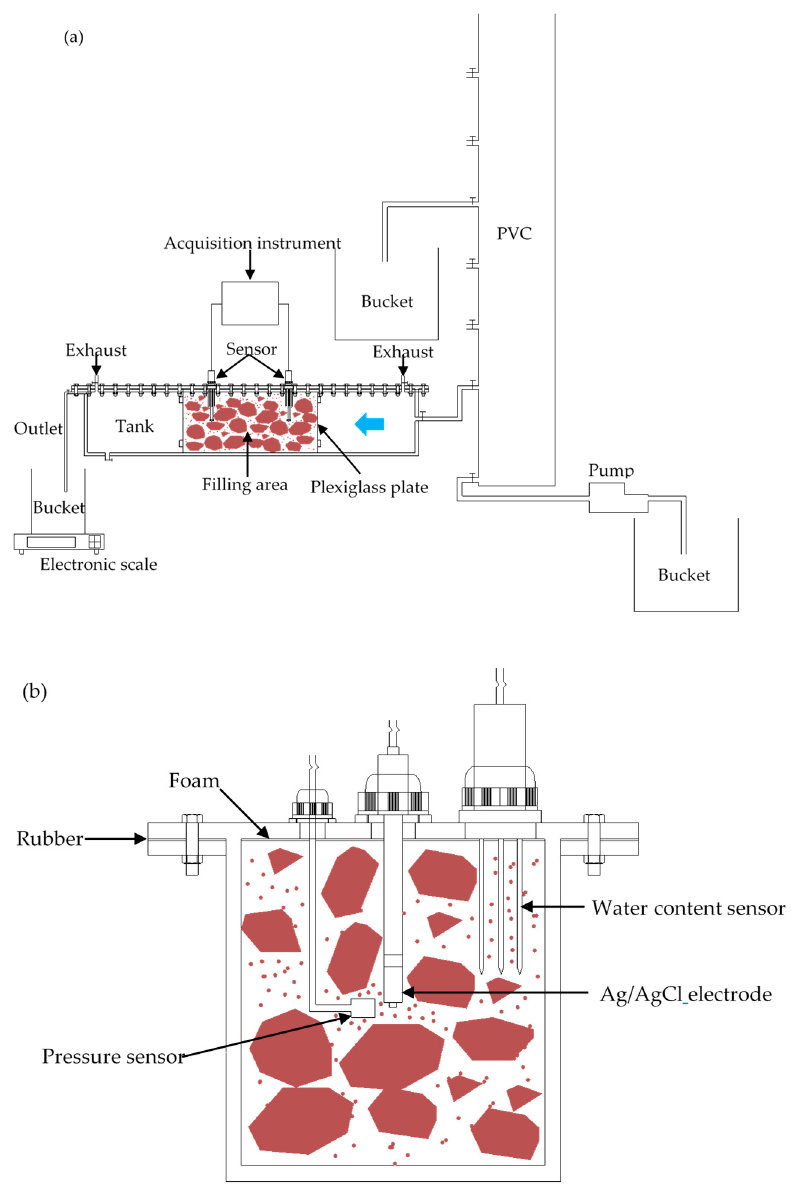
Figure 1. Sketch of the experimental apparatus. ( a ) The apparatus consists of tank (filling area, plexiglass plate, exhaust, outlet), PVC pipe (pump, bucket), and data acquisition system (sensor and acquisition instrument), the blue arrow represents the direction of the water flow. ( b ) Cross section through the sensor (water content sensor, Ag/AgCl non-polarizable electrode, pressure sensor, rubber, foam).